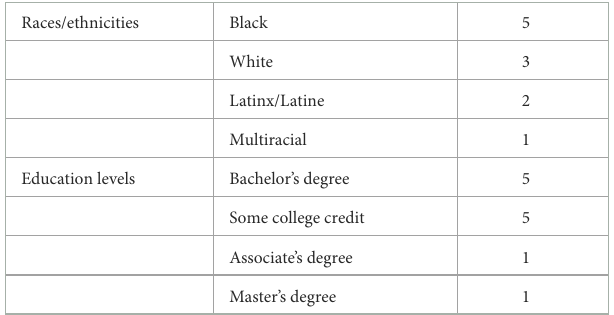
TABLE 2 Participant demographics.